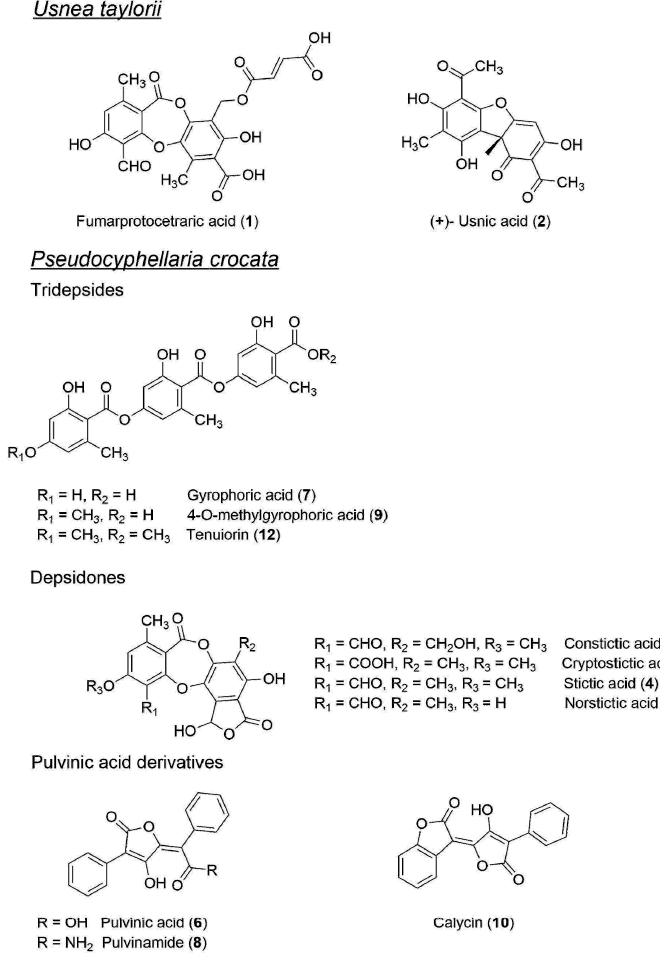
Figure 3. Structures of the compounds identified in Usnea taylorii and Pseudocyphellaria crocata collected on Possession Island (Crozet Archipelago).